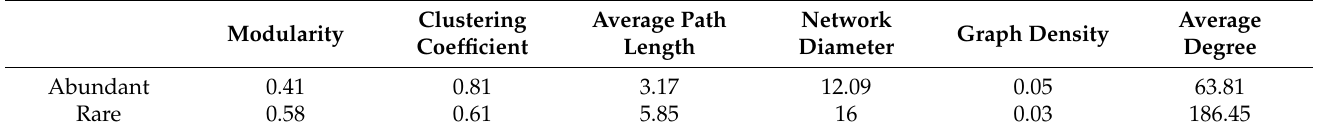
Figure 3. Co-occurrence networks of abundant and rare taxa. The size of the node represents the degree of OTUs. The dotted line between the OTUs represents the positive (red) correlation and negative (green) correlations. Table 2. Topological properties of co-occurrence networks of the abundant and rare bacteria.